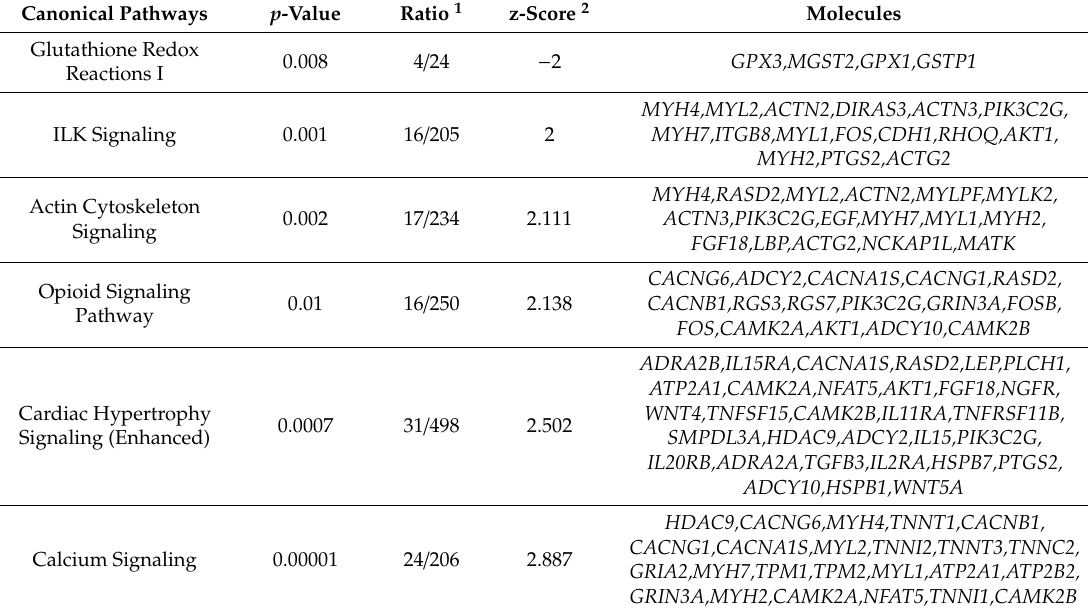
Table 2. Ingenuity Pathway Analysis (IPA) -based list of pathways in the set of di ff erentially expressed genes (DEGs) according to breed ( p -value < 0.01, z-score > 2 or < − 2). Canonical Pathways p -Value Ratio 1 z-Score